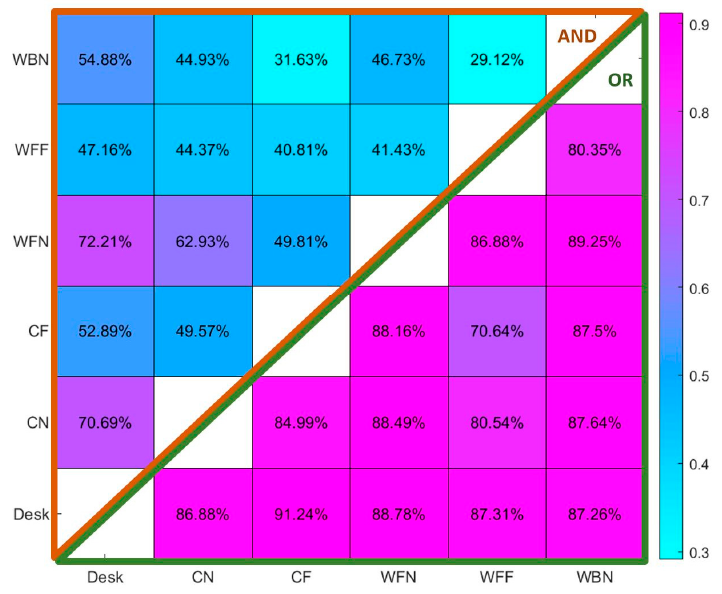
Figure 5. Accuracy of presence detection by pairwise fusion of PIR sensors.